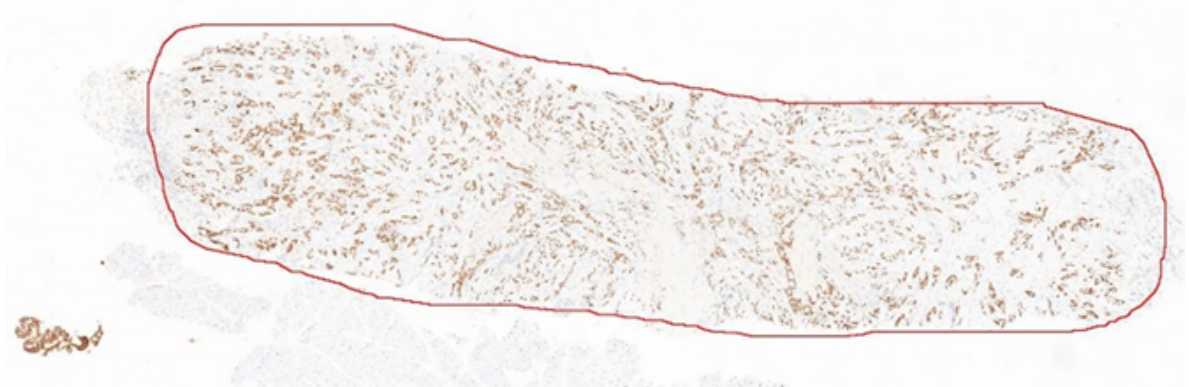
Figure 7. Example of the whole-slide image used in the Allred scoring